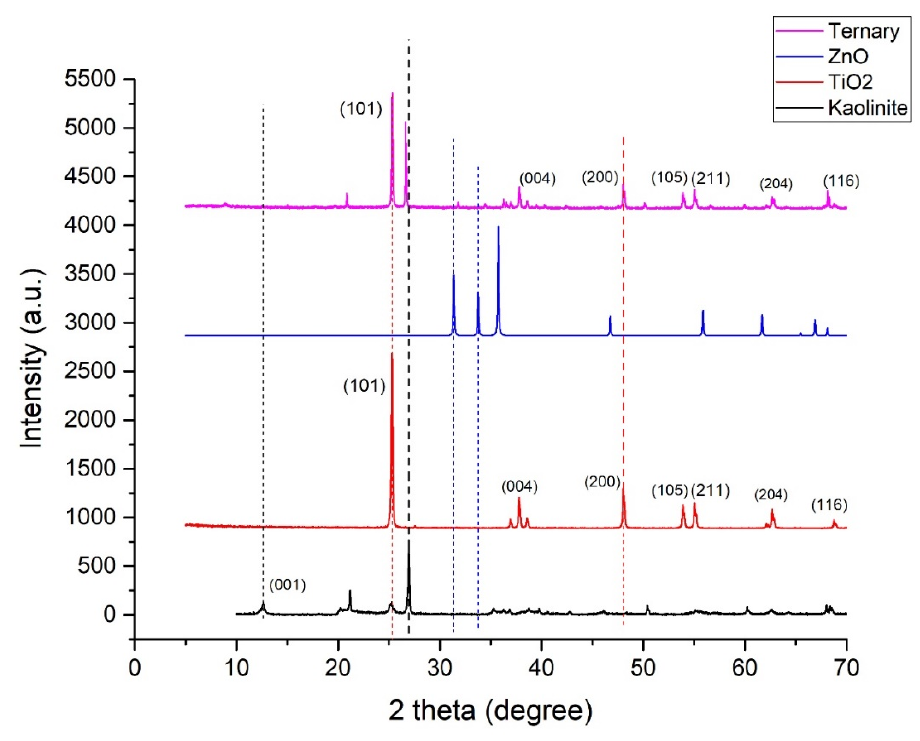
Figure 4. XRD patterns for kaolinite, TiO 2 , ZnO, and ternary nanocomposite.